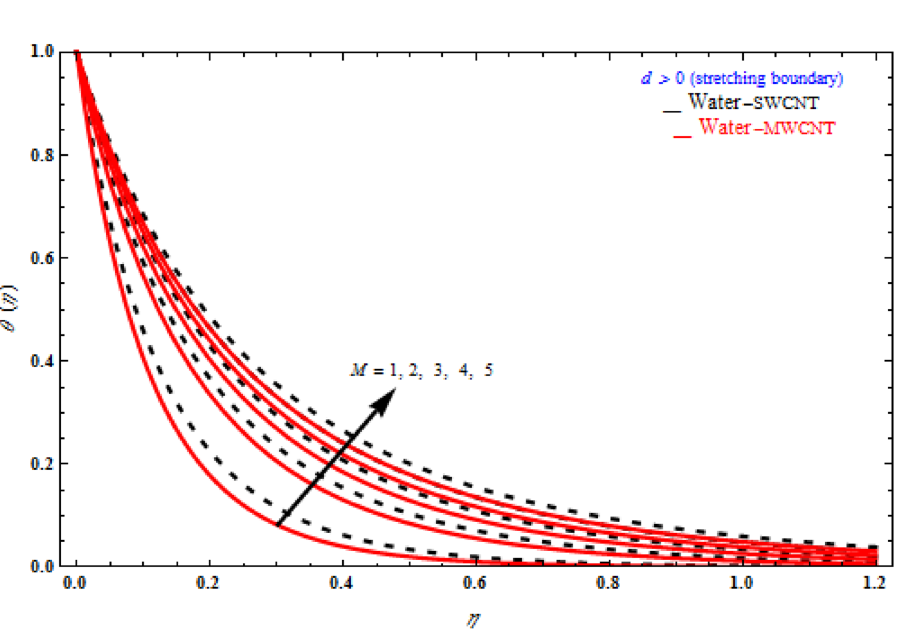
Figure 9. Influence of M on temperature with k 1 = 1, Da -1 = 1, N R = 1, τ = 90° for stretching